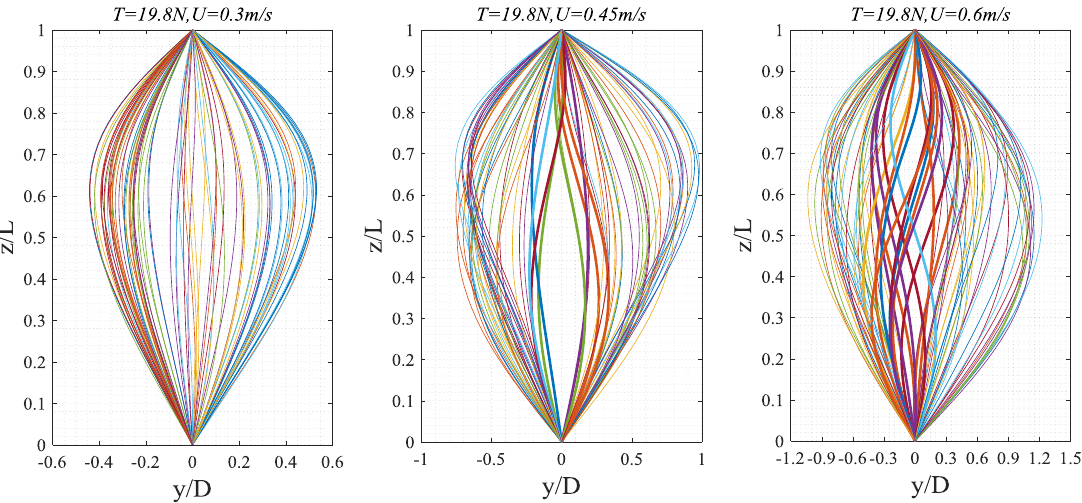
Figure 10. Each (1/20) s of the riser forms a cross-flow deflection curve in motion, T = 19.8 N, U = 0.3 m/s, U = 0.45 m/s, U = 0.6 m/s.